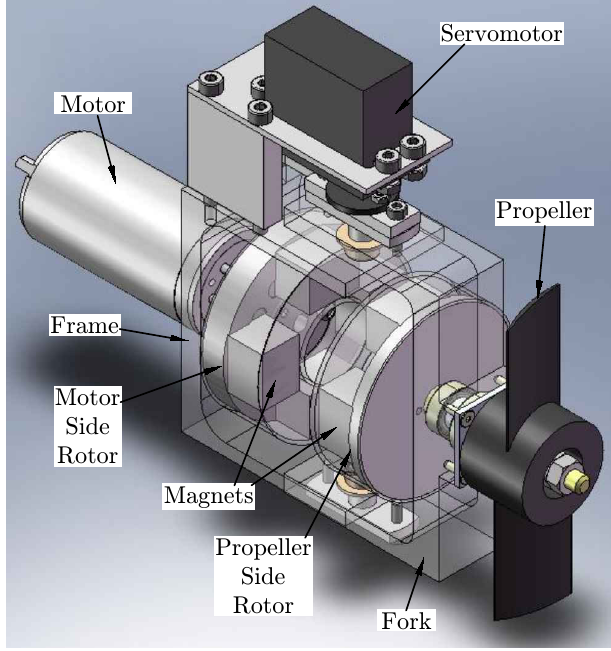
Figure 1. Flat-RMCT CAD